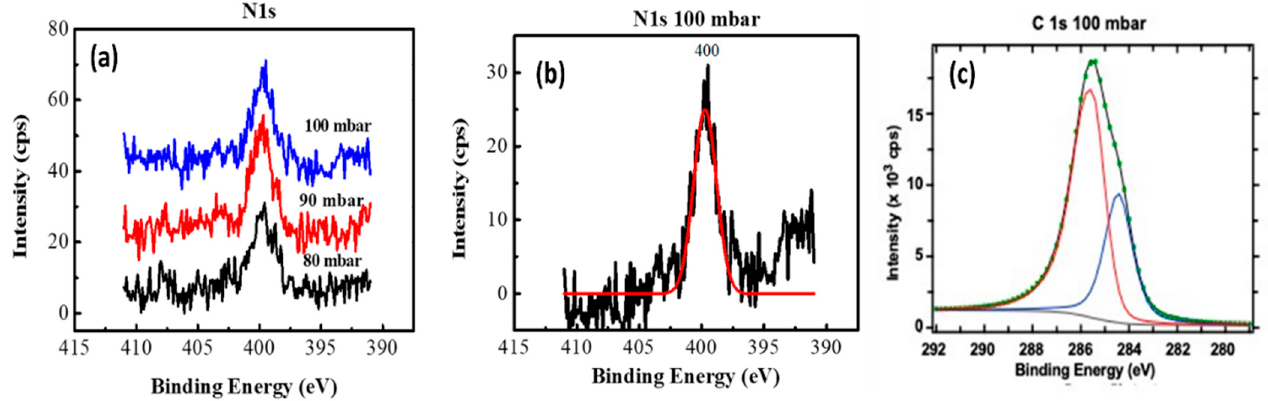
Figure 3. N 1s and C 1s XPS peaks from N-UNCD films grown at ( a ) 80, 90, and 100 mbar, at 4500 W; ( b ) N 1s XPS peak from N-UNCD film grown at 100 mbar; and ( c ) C 1s XPS peak from N-UNCD film grown at 100 mbar.